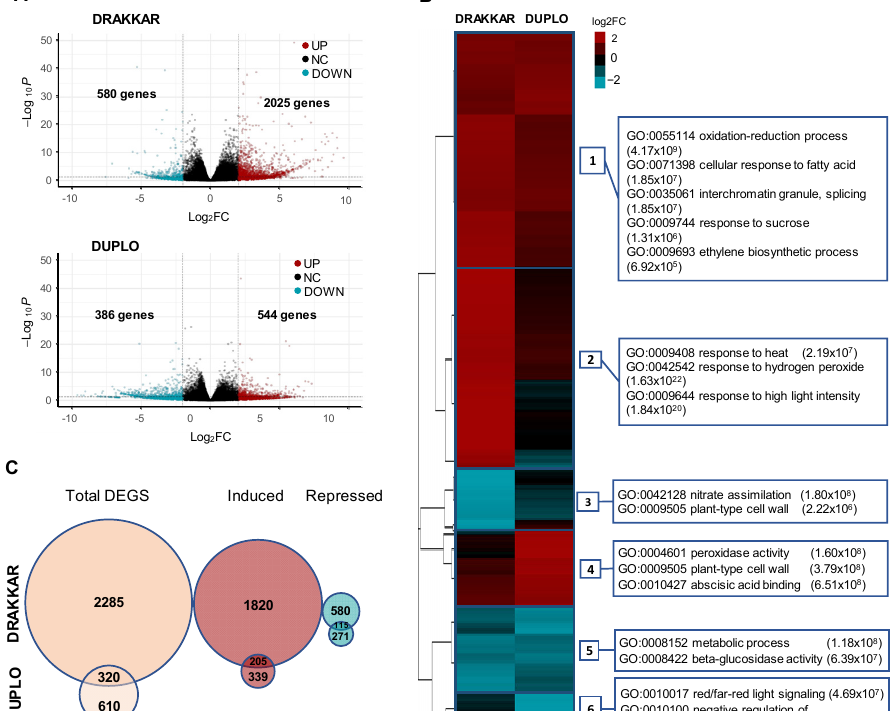
Figure 5. B. napus genotypes modify their transcriptional programs to modify their root growth to respond to warm temperatures. ( A ) Volcano plot of average gene expression changes and number of all differentially expressed genes (DEGs) of Drakkar and Duplo root tips grown at 21 °C compared to 29 °C, representing a total of 3215 unique genes with altered expression at 29 °C. x -axis represents fold changes (Log2FC), and y -axis represents statistical significance ( − Log10 of p value, − Log10p). The dashed lines show where − 1 > log2FC > 1 and adjusted p value > 0.05 are located. Maroon dots represent upregulated genes, blue dots are downregulated, and black-grey dots represent no significant gene expression change. ( B ) Transcriptional changes of DEGs in response to warm temperatures in Drakkar compared to Duplo. Differential genes were hierarchically clustered into six groups, based on differences in log2FC ratio. Upregulated genes are represented in maroon, and downregulated genes are in blue. Each cluster of the heatmap is accompanied on the right by the most significant functional categories (GO categories) and their corresponding p -value in brackets. ( C ) Venn diagram showing total (orange), upregulated (maroon), and downregulated (blue) DEGs of Drakkar and Duplo root tips grown at 21 °C compared to 29 °C).